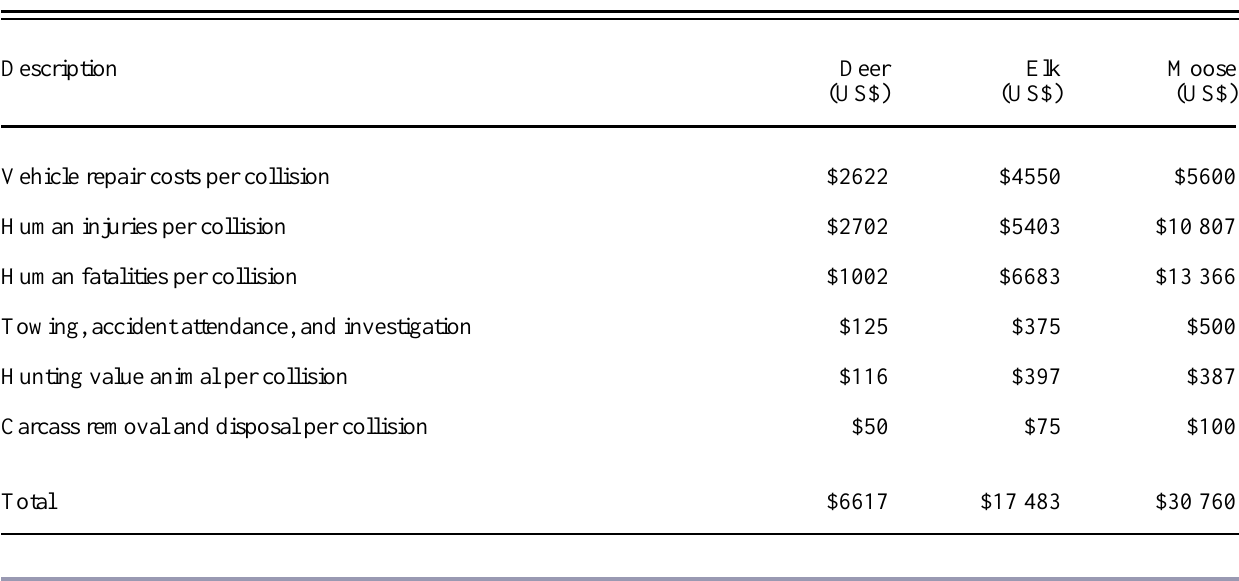
Table 2. Summary of estimated costs (in 2007 US$) for the average deer–, elk–, and moose–vehicle collision.